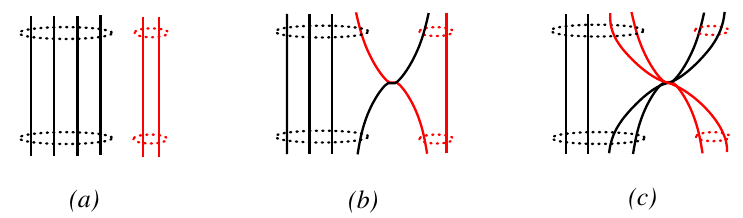
(cid:41)(cid:76)(cid:74)(cid:17) (cid:20)(cid:24)(cid:17) Diagrammatic representation of: ( a ) “direct”, ( b ) “single-exchange”, and ( d ) “double-exchange” components of the norm kernel for the ( A − 2 , 2) cluster basis. The first group of circled lines represents the first cluster, the bound state of A − 2 nucleons. The second couple of circled lines represents the second cluster, in the specific case a deuteron nucleus. Bottom and upper part of the diagram represent initial and final states, respectively. See also caption of fig. 1.